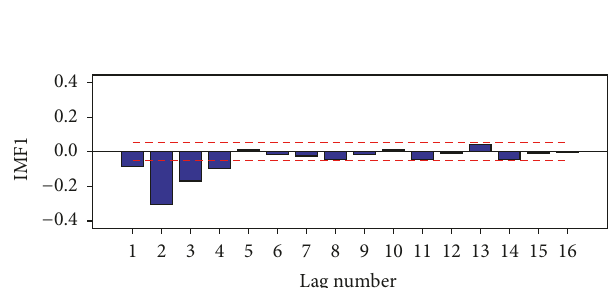
Figure 5: PACF for subseries IMF 1 (Case